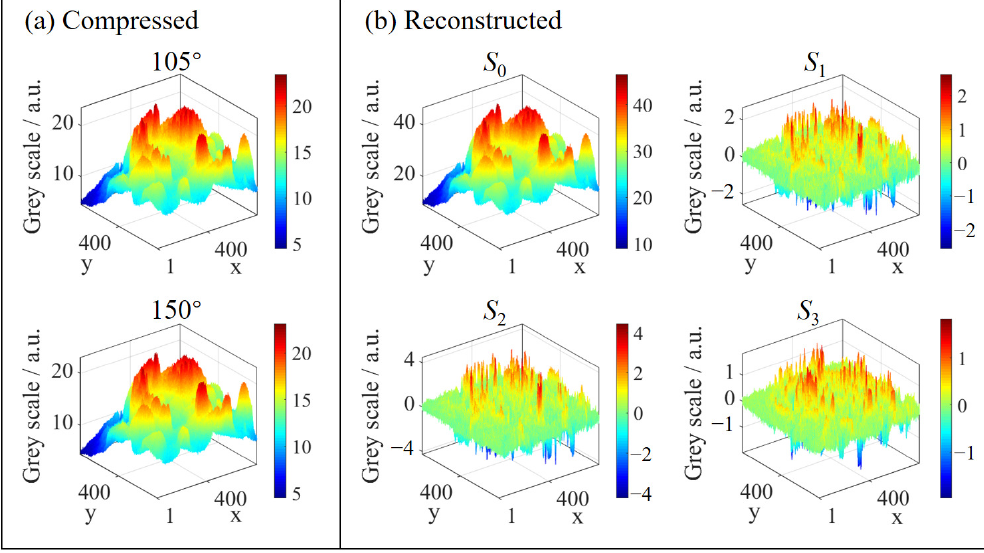
Figure 5. The grey distribution of ( a ) compressed images and ( b ) reconstructed polarized images in the spectral band of 600